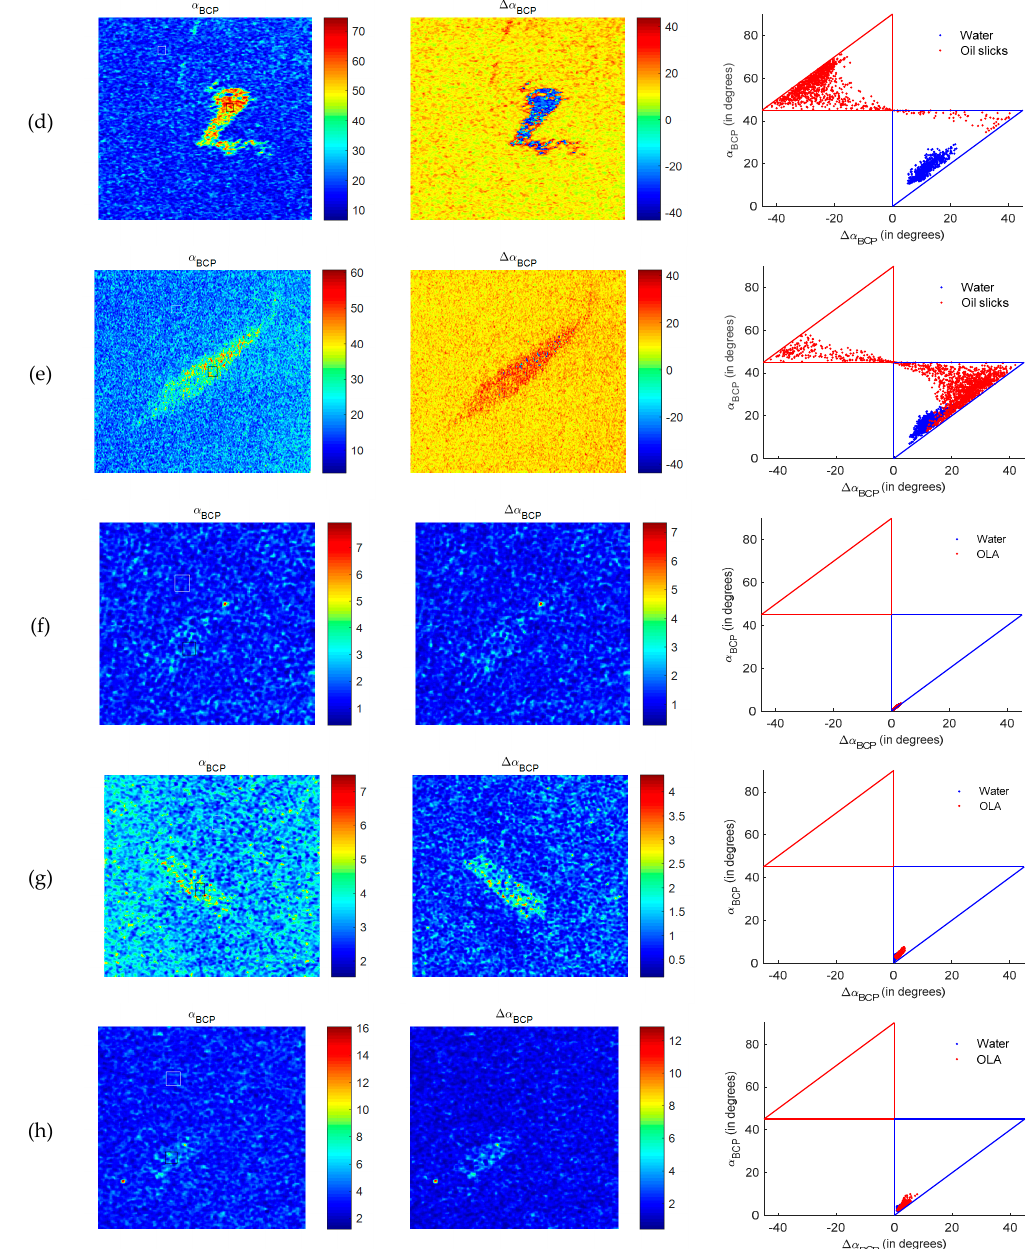
Figure 6. CP parameters in the left circular mode and the ∆ α BCP / α BCP scatter plots. ( a – h ) used data from ALOS / PALSAR-1 with ALPSRP031440190, RADARSAT-2 (Penglai 19-3 oil field), and the SIR-C data sets with p.n. 17041, 44327, 49939, 41467, 11588, and 41370, respectively.